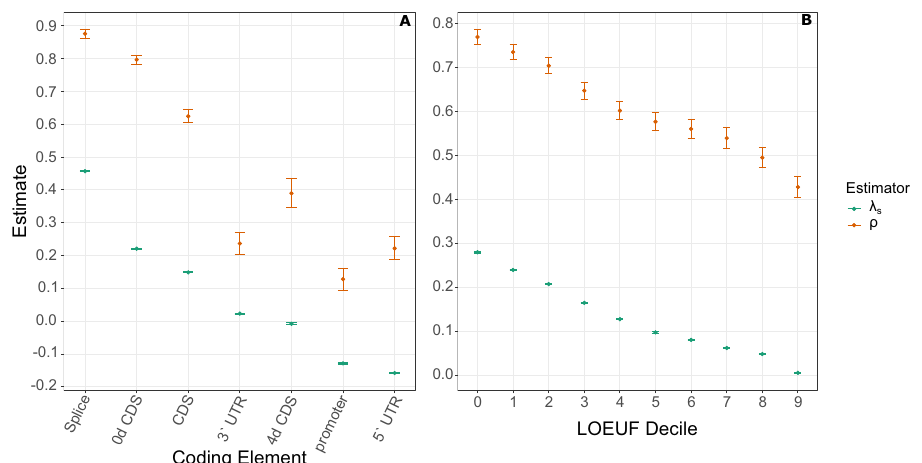
Fig. 1 Measures of purifying selection at coding and coding-proximal genomic elements. A Estimates for various annotation types are shown for both ExtRaINSIGHT ( λ s ; teal) and INSIGHT ( ρ ; orange). B Similar estimates are shown for protein-coding genes by deciles of the loss-of-function observed/ expected upper bound fraction (LOEUF) measure 13 . Results are shown for 80,950 isoforms of 19,677 genes. Notice that lower LOEUF scores are associated with stronger depletions of LoF variants, so λ s and ρ tend to decrease as LOEUF increases. Error bars are centered at the MLE and indicate one standard error in each direction (see “ Methods ” ).